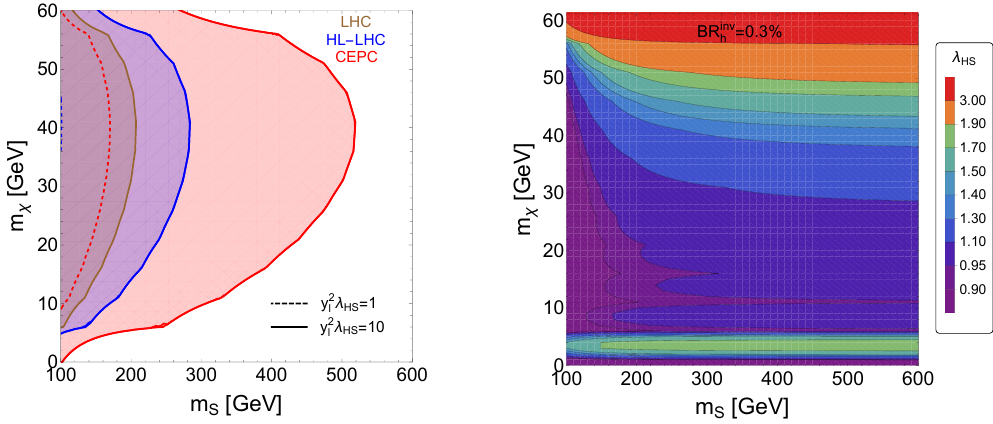
λ HS at different colliders. ‘ if we fix y = y th from HS ‘ ‘